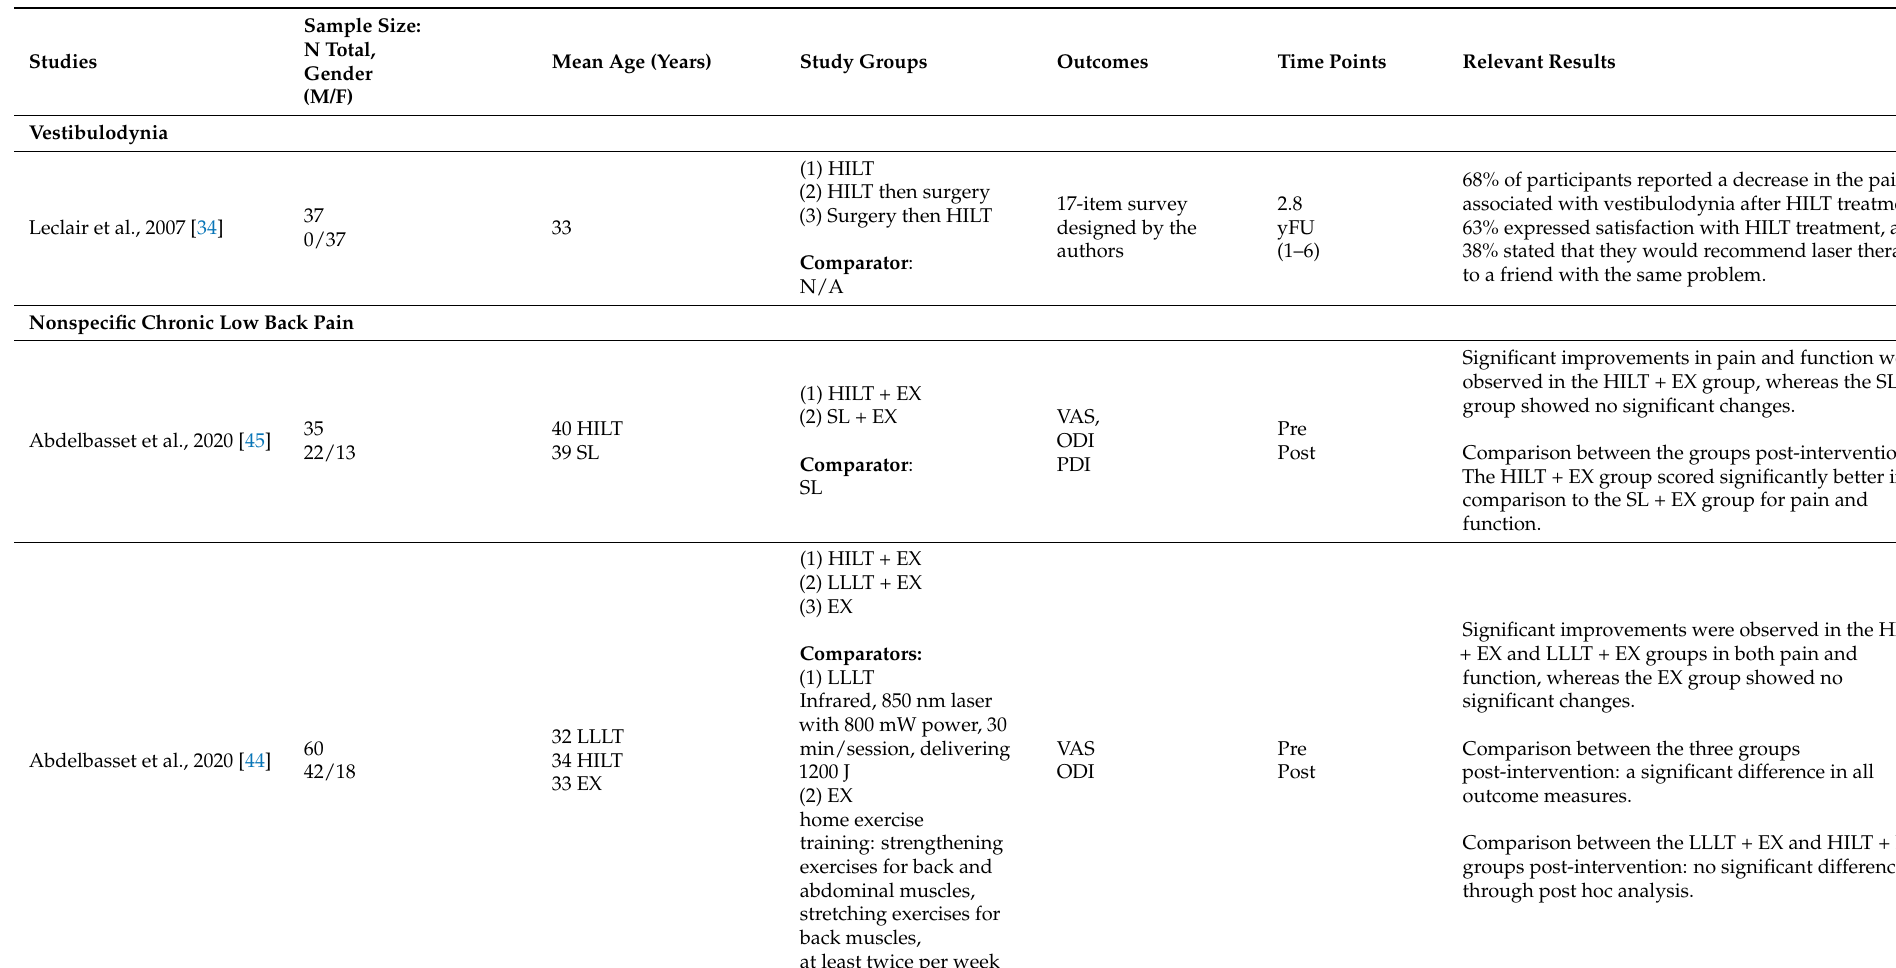
Table 2. Characteristics of the studies